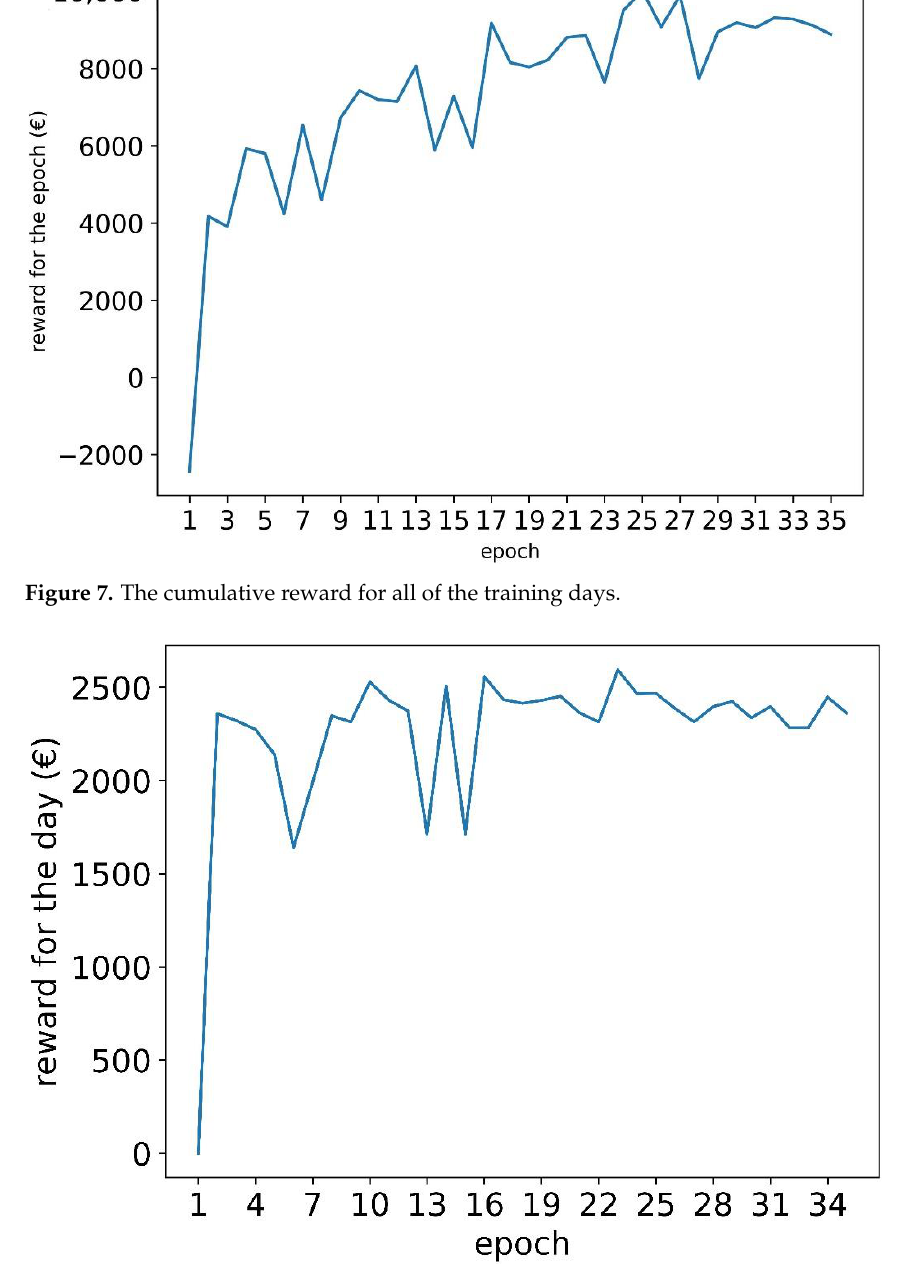
Figure 8. The cumulative reward for all the validation days.